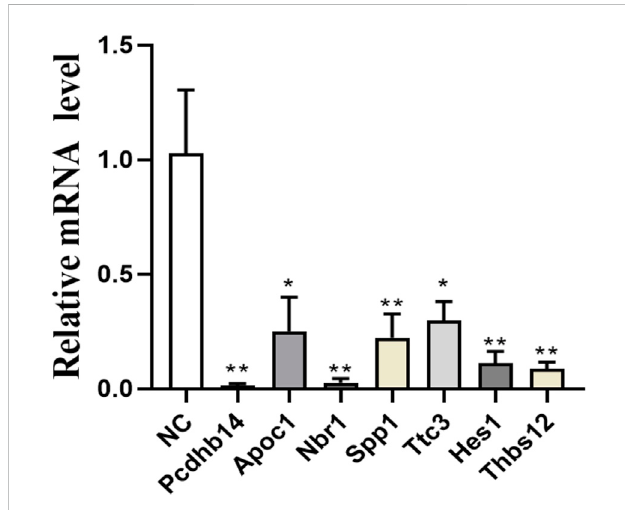
FIGURE 5 Expression of Pcdhb14, Apoc1, Nbr1, Spp1, Ttc3, Hes1, Thbs1 genes after loperamide treatment by QPCR (*p < 0.05; **p <